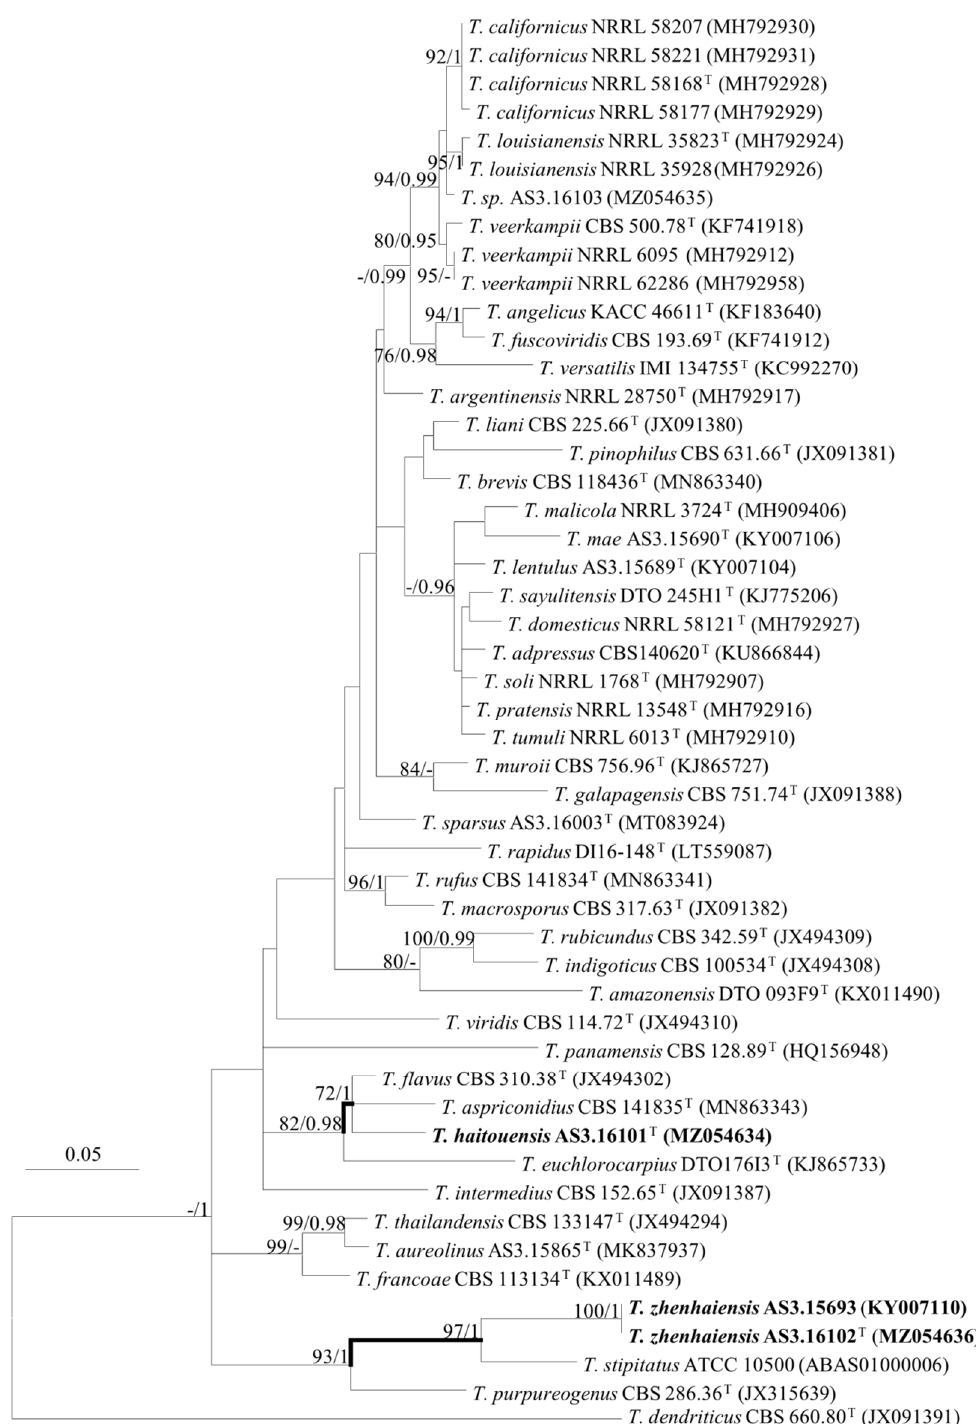
Figure 2. ML phylogram inferred from partial BenA sequences. Bootstrap percentages over 70% derived from 1000 replicates and posterior probabilities over 0.95 of BI are indicated at the nodes. T indicates ex-type strains, strains belonging to new species are indicated in boldface. Scale Bars: number of substitutions per nucleotide position.